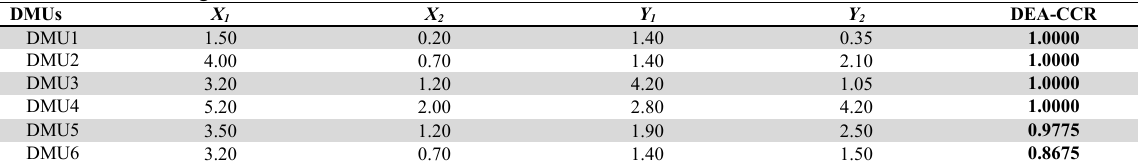
Data set of six nursing